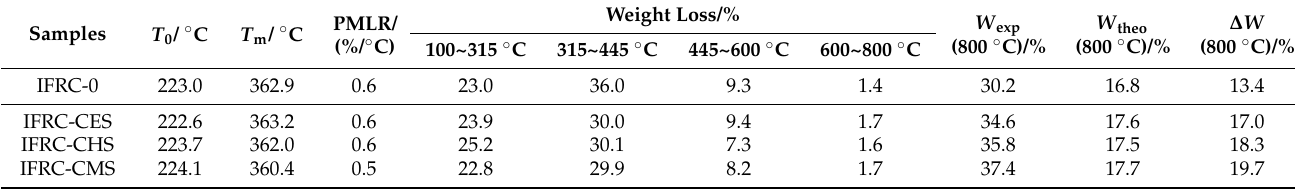
Table 5. Thermal data of the IFRCs under nitrogen